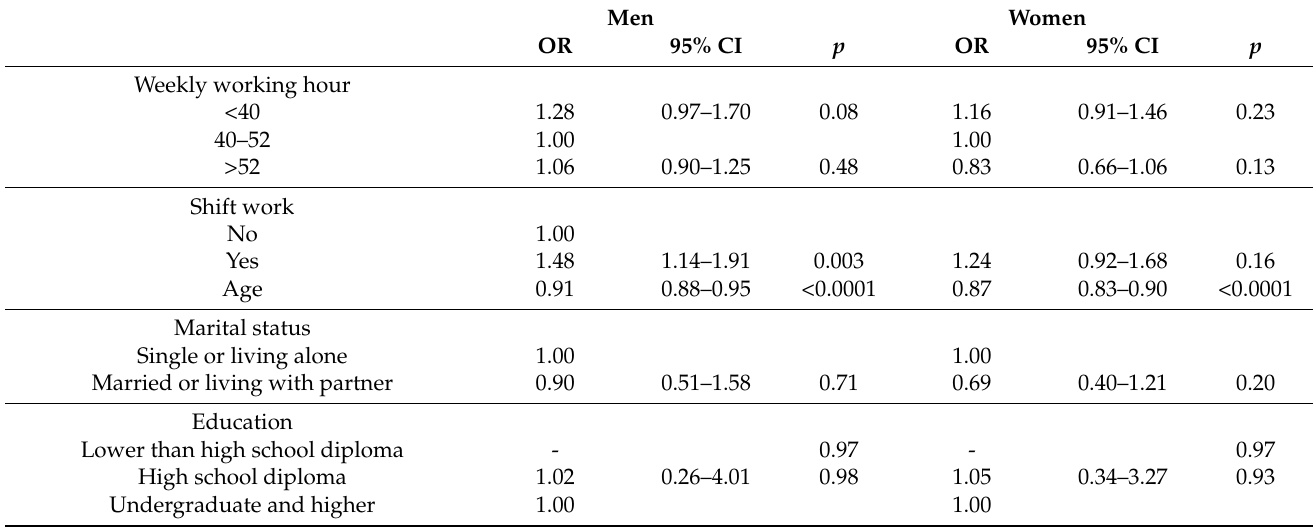
Table 2. Results from fixed effect logit models for the association between working hours and perceived unmet dental